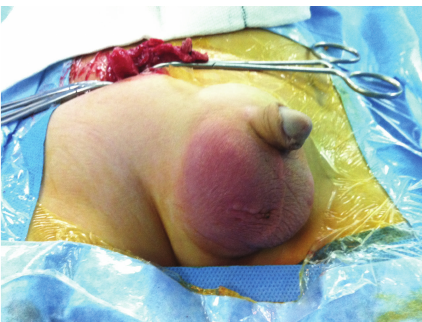
Figure 1: Right erythematous and testicular swelling mimicking acute scrotum.